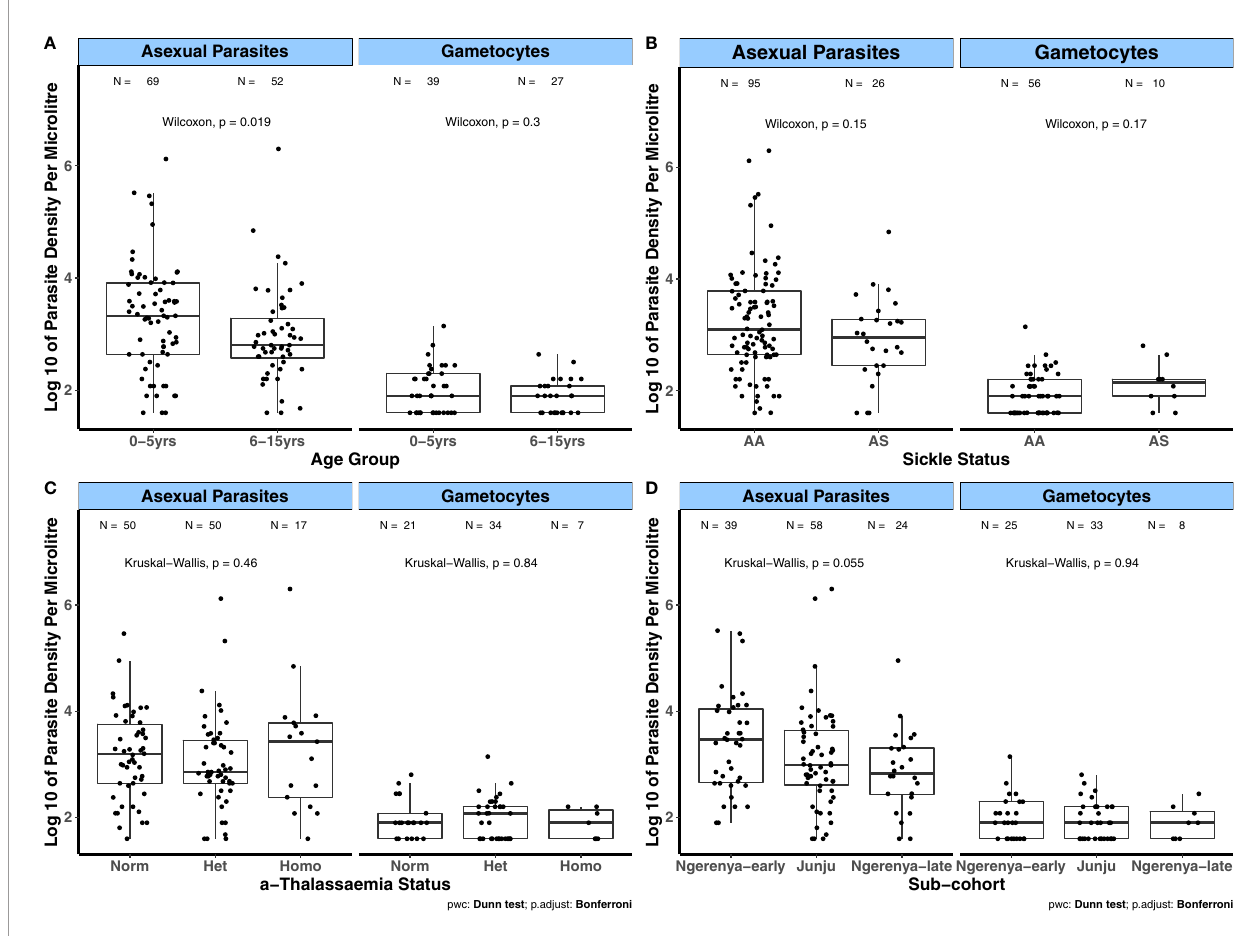
FIGURE 1 | Variation in patent parasite densities by factors associated with gametocyte carriage in the KMLC cohort. Asexual parasite and gametocyte densities by (A) Age group; (B) Sickle genotype; and (C) a -thalassaemia genotype. (D) Sub-cohort (moderate transmission (Ngerenya-early and Junju) and low transmission (Ngerenya-late)). Comparisons were carried out using the Wilcoxon test and Kruskal-Wallis test (post-hoc analysis after Kruskal-Wallis carried out using Dunn ’ s test with Bonferroni correction). The number of parasite positive individuals (N) is indicated at the top of each graph. a -thalassaemia: Norm – normal, Het – heterozygous, and Homo – homozygous. The boxes of boxplots display the median bound by the fi rst and third quartiles, with the whiskers depicting the lowest and highest values (excluding outliers). The dots indicate individual data